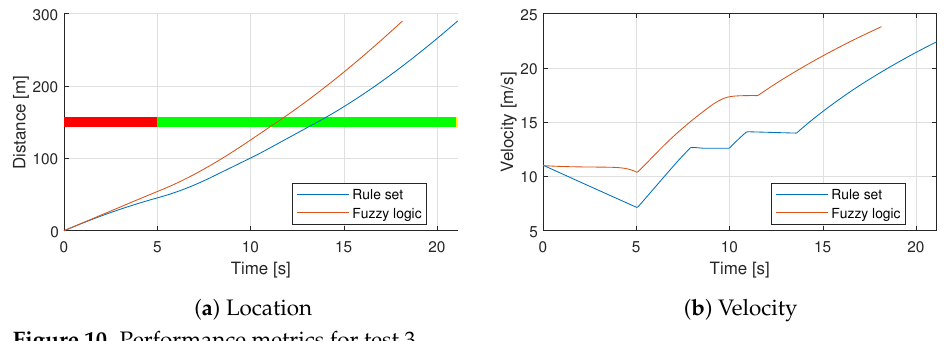
Figure 10. Performance metrics for test